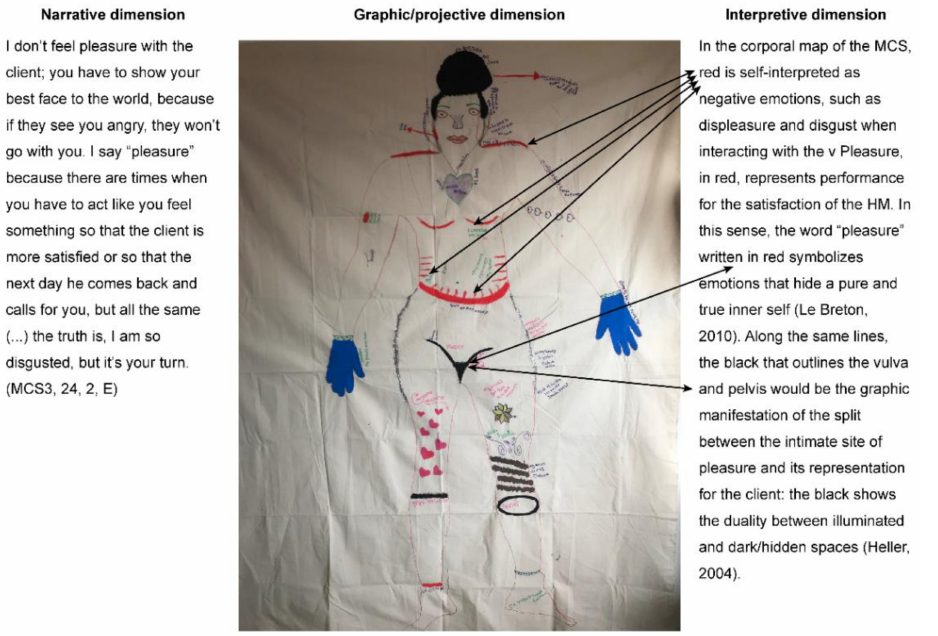
Figure 3. Example matrix narrative analysis. Source: Author.